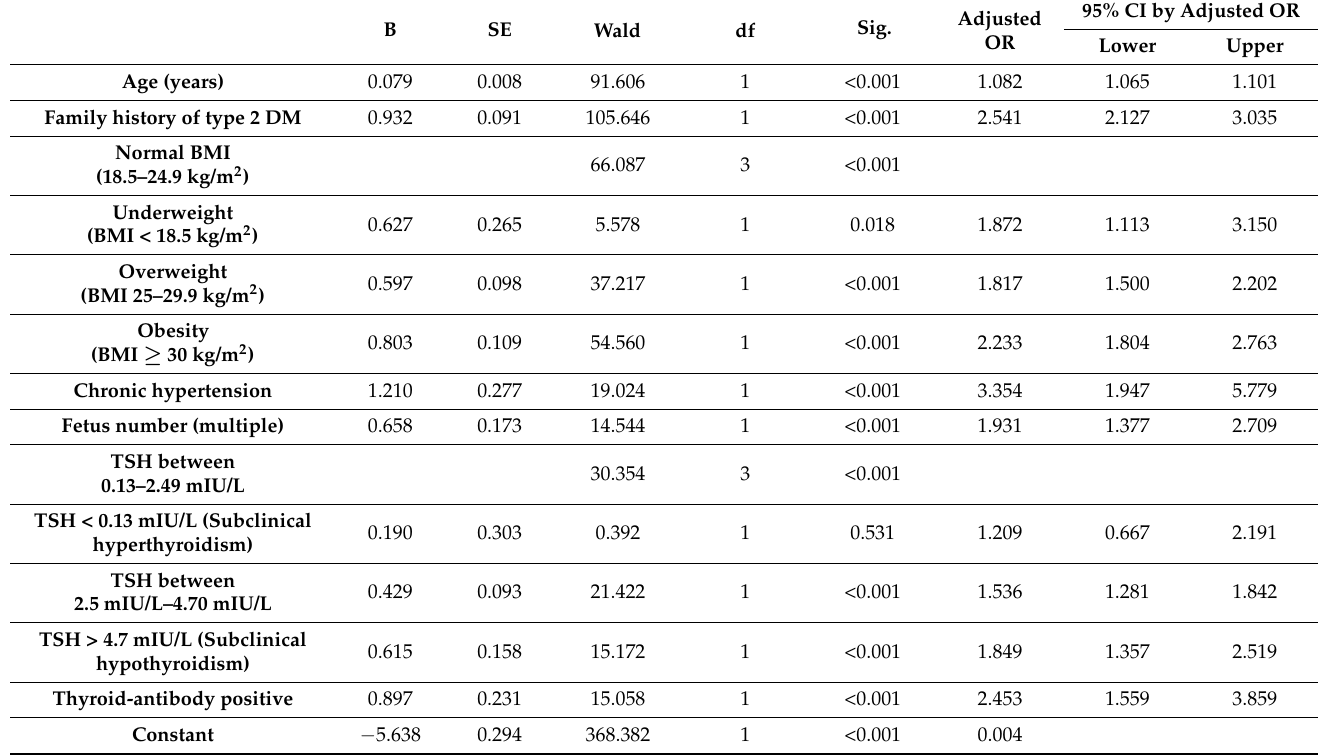
4.71 mIU/L showed 1.85 times higher risk of GDM (adjusted OR = 1.94; 95% CI = 1.36–